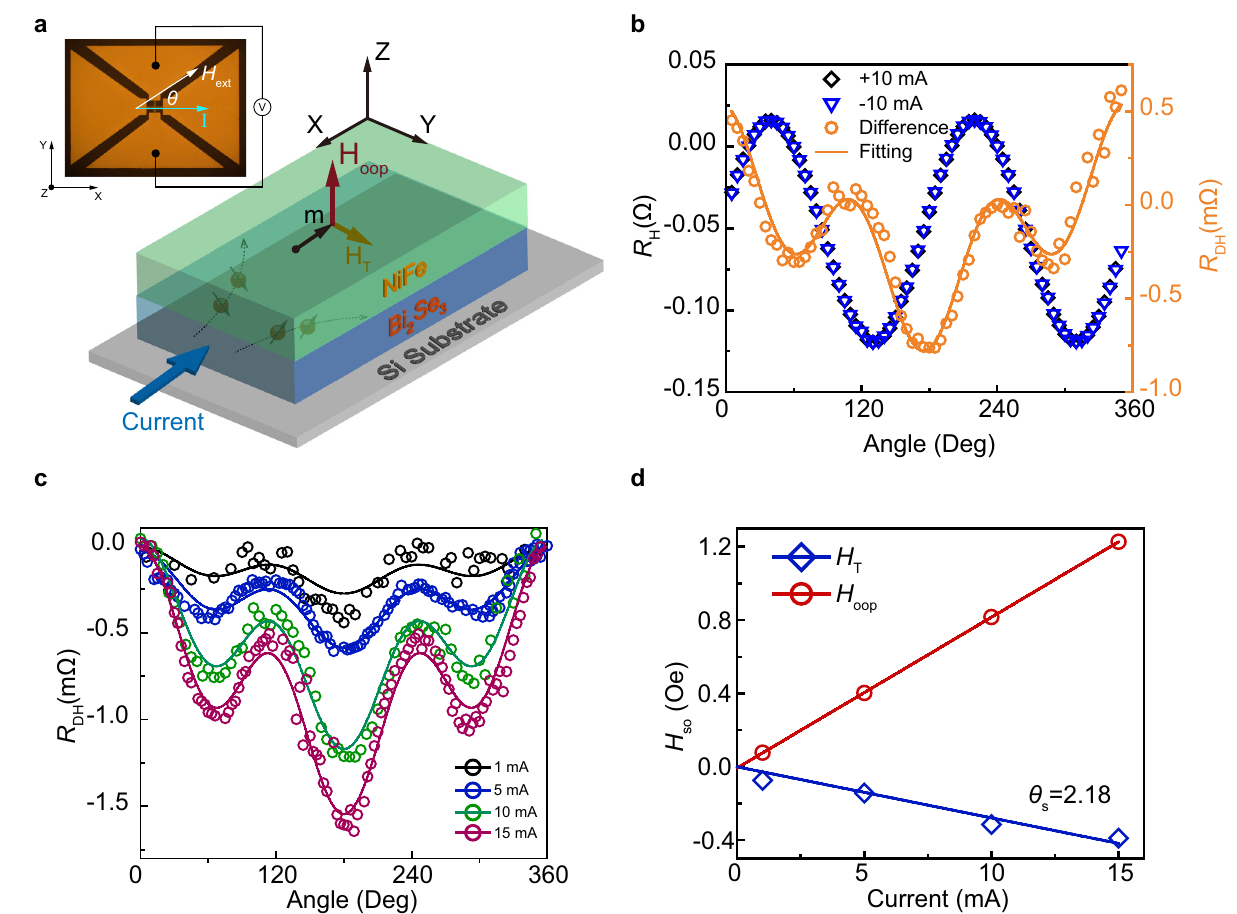
Fig. 2 Determine the SOT-induced effective fi eld and spin Hall angle by planar Hall effect. a Schematic for the coordinate system and the SOT-induced effective fi elds considered in the NiFe/Bi 2 Se 3 heterostructure. The inset is a top view of the Hall device by optical microscopy and the layout for the planar Hall measurement. b Planar Hall resistance R H of NiFe/Bi 2 Se 3 at ±10 mA applied current as a function of the external magnetic fi eld angle θ . The right axis represents the difference of the Hall resistances R DH at positive and negative currents. c Angular-dependent R DH measured at different input currents. Each solid curve represents the fi tting result. d SOT-induced effective fi elds H OOP and H T as a function of applied current. The lines are the linear fi tting